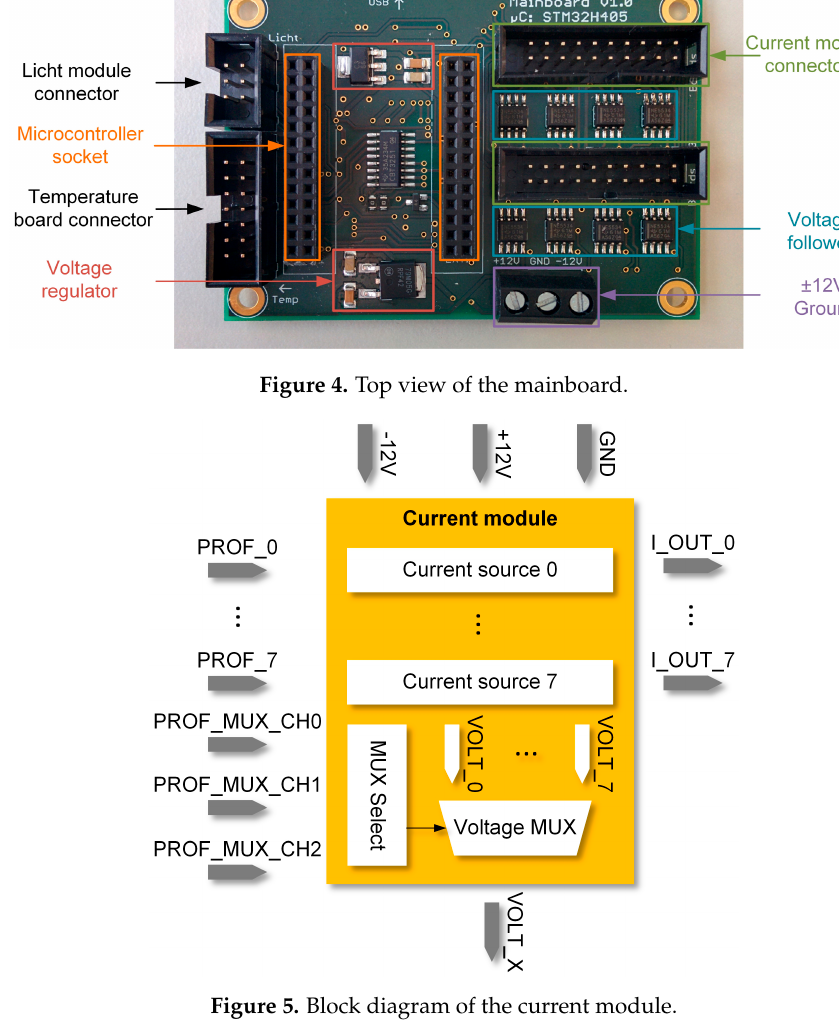
Figure 5. Block diagram of the current module.